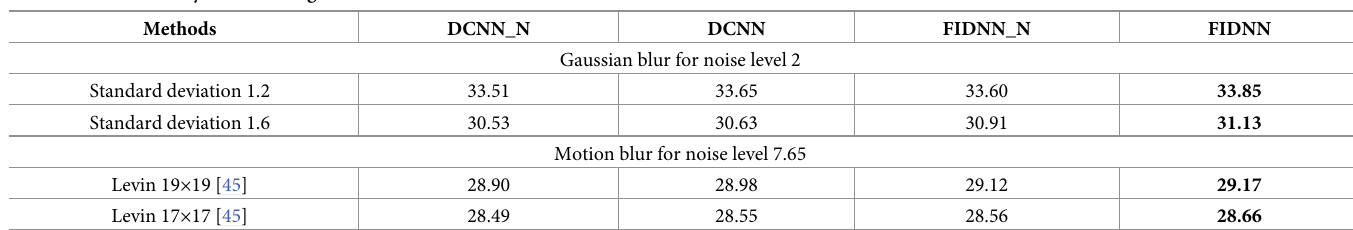
Table 2. Ablation study of deblurring on Set10 dataset.